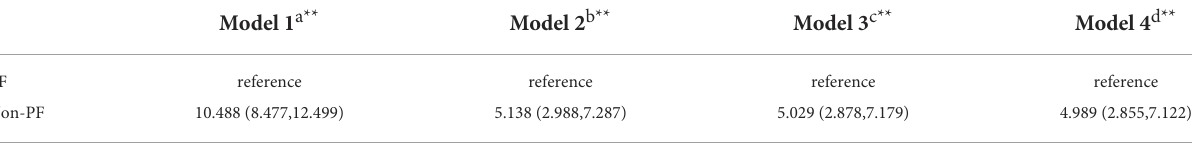
TABLE 2 The associations between physical frailty and serum levels of 25(OH) D 3 (nmol/L).